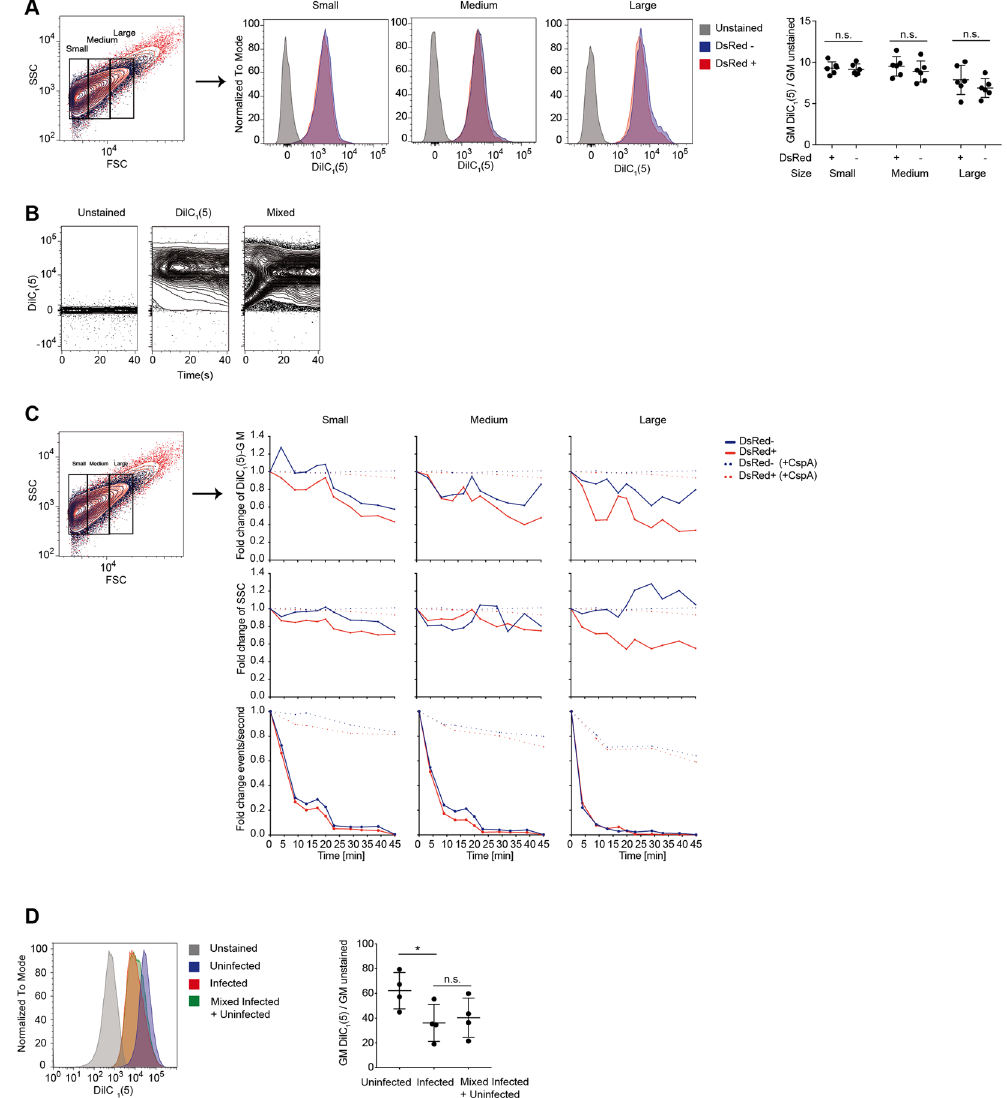
Figure 4. Mitochondrial cross-talk impacts on membrane potential. ( A ) Flow cytometric analysis and quantification of mitochondrial membrane potential by DilC 1 (5) (100 nM) of isolated mitochondria from Ad-CMV-mitoRL-infected mice (5 × 10 8 pfu/mouse). Mitochondria were gated on mitochondria from infected cells (DsRed + ) and mitochondria from uninfected cells (DsRed − ). Membrane potential is plotted as staining intensity of DilC 1 (5) (100 nM). Six independent experiments were used for statistical analysis. ( B ) Flow cytometric analysis over time of DilC 1 (5) labelled mitochondria mixed with unstained mitochondria (measurement immediately after mixing both samples). ( C ) Flow cytometric analysis at indicated time points after challenge with calcium of purified DsRed- and DsRed + mitochondria isolated from Ad-CMV-mitoRL- infected livers (5 × 10 8 pfu/mouse). Mitochondria were stained with DilC 1 (5) and challenged with 100 µ M calcium with or without Cyclosporin A (5 µ M); fold change in DilC1(5) geo-mean, SSC and events/second were plotted against time. ( D ) Flow cytometric analysis and quantification of membrane potential by DilC 1 (5) staining of mitochondria from uninfected livers with mitochondria from Ad-CMV-GOL infected livers at a ratio 1:1. Samples were mixed before staining procedure (measurement 1 h post staining). Four independent experiments were used for statistical analysis. Unless stated otherwise, data are representative from at least three independent